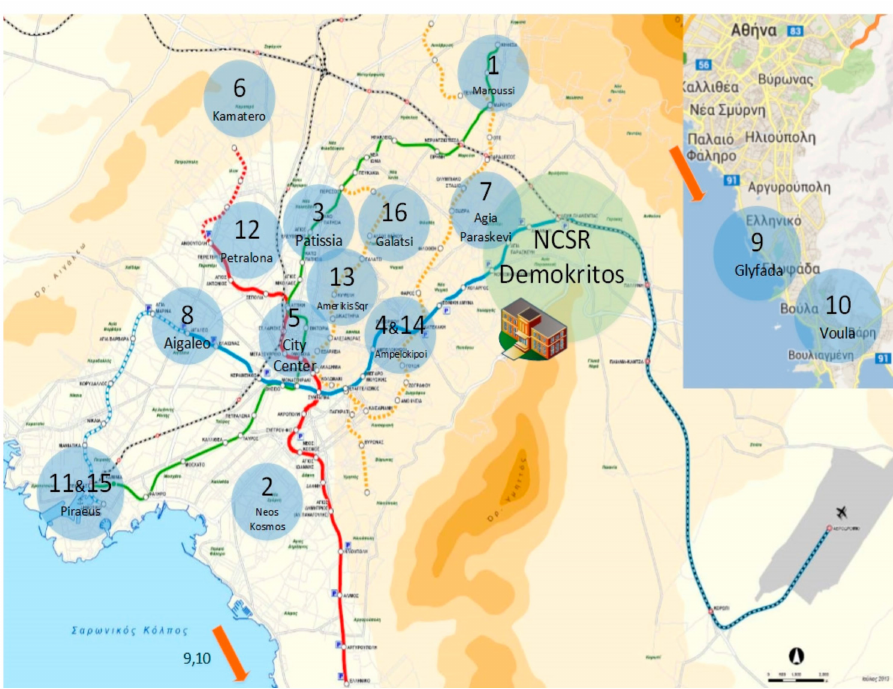
Figure 1. Map of Athens city and suburbs. Participants’ code (1–16) and the areas of each residence are marked with a blue circle. Metro and train routes are marked with red, blue, and green lines. Bus route to/from NCSR Demokritos (green circle) is marked with a black dashed line.